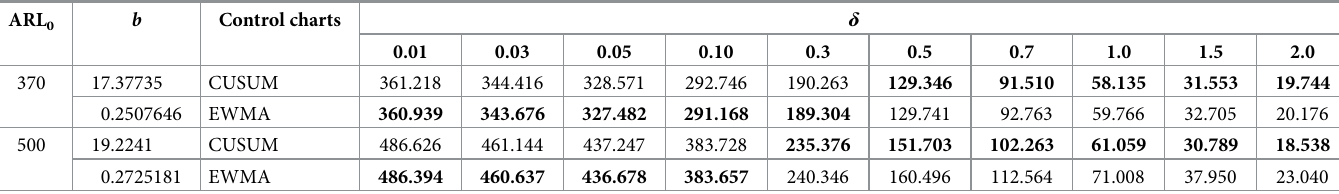
Table 9. Comparison of the ARL 1 values obtained via the analytical IE on a CUSUM control chart and a numerical IE method on a EWMA control chart with λ = 0.1 for detecting changes in the mean of the long-memory SARFIMAX(1, 0.496151, 1 1) 12 process. ARL